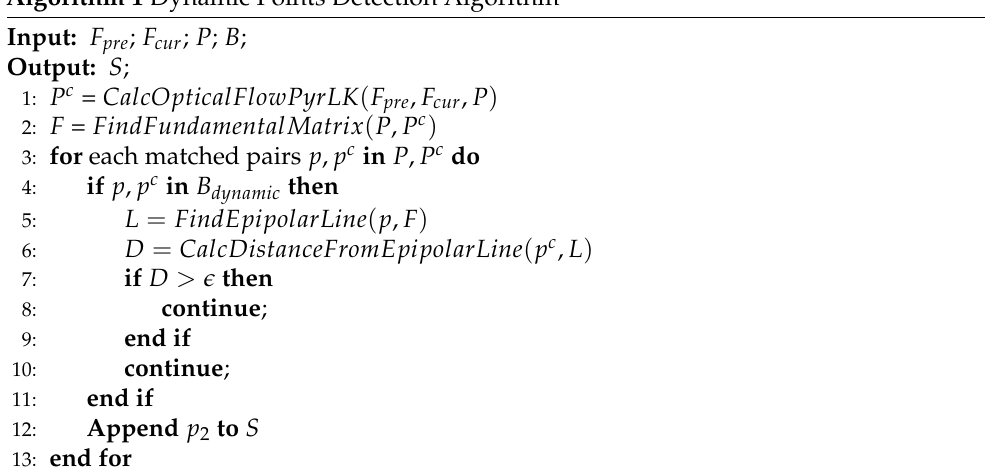
Algorithm 1 Dynamic Points Detection Algorithm